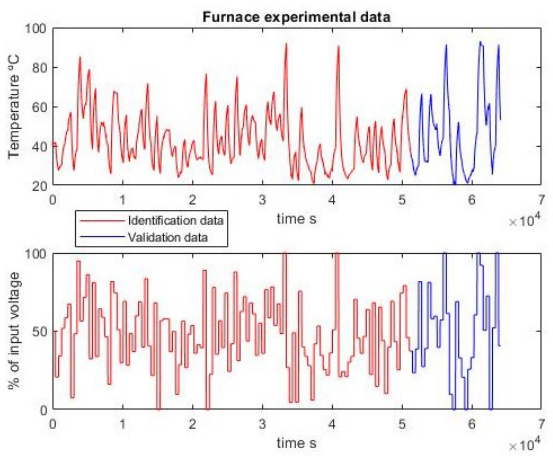
Figure 3. Furnace experimental data for identification and